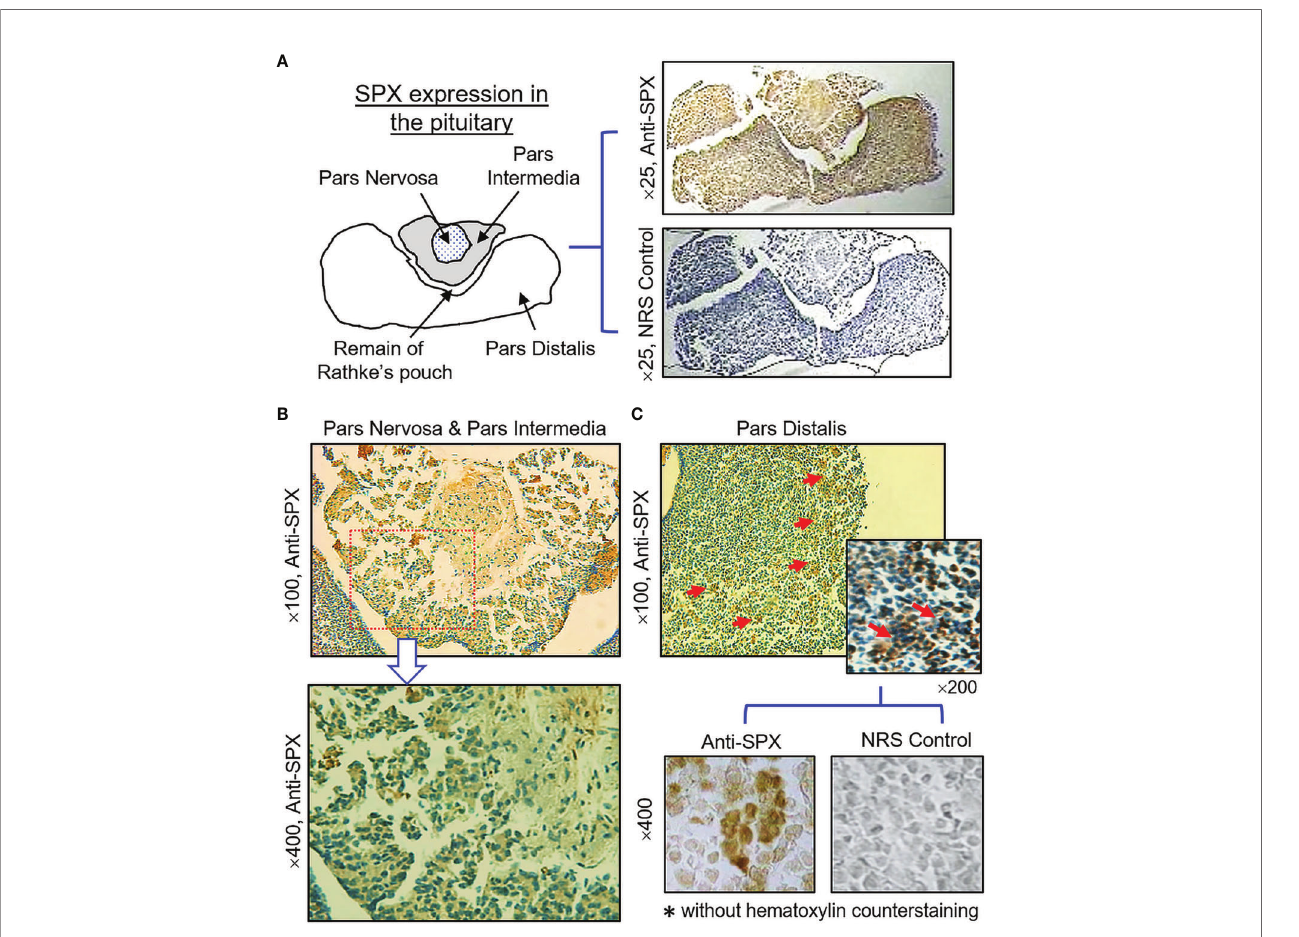
FIGURE 11 | Histological distribution of SPX expression in the pituitary. (A) Immunoreactivity of SPX detected by anti-SPX in the mouse pituitary covering the areas of pars nervosa, pars intermedia and pars distalis. (B) SPX expression in the pars nervosa and pars intermedia. SPX signals were located in pituitary cells forming the matrix of pars nervosa and pars intermedia. (C) SPX expression in the pars distalis. SPX immunostaining was observed in cell clusters located in the outer edge of the pars distalis. In this study, parallel staining with NRS was used as the negative control and the numbers on the side (×25, ×100, ×200, and ×400) represent the magni fi cation of the respective